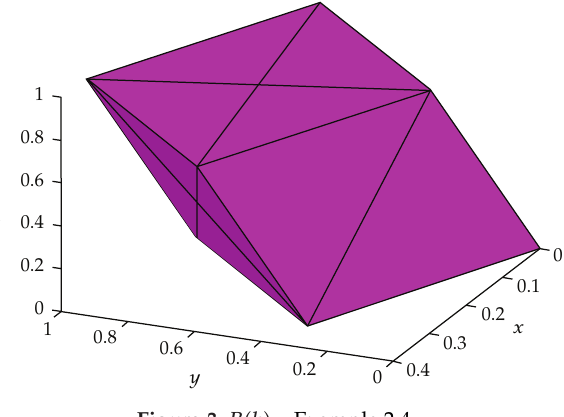
Figure 3: B (cid:2) b (cid:3) —Example